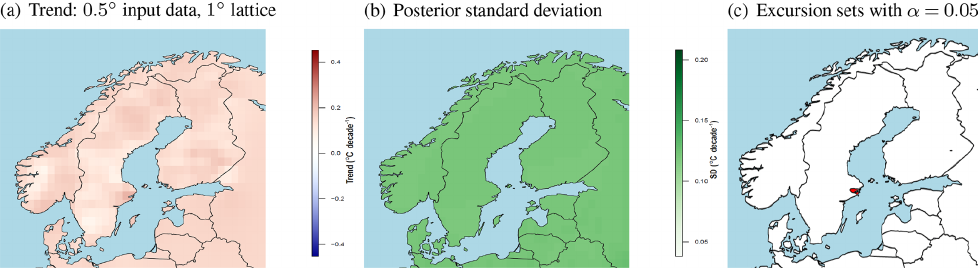
Figure 2. Trend estimates for Fennoscandia based on input data on a 0.5 ◦ grid. (a) Posterior mean estimates of the trend coefficient (in ◦ Cdecade − 1 ) projected on a regular 1 ◦ lattice. (b) Posterior standard deviation of the trend coefficient on the same lattice. (c) Avoidance excursion set where the spatial null hypothesis of no trend is rejected for the level α = 0 . 05 (red). Note that the estimates outside Fennoscandia are based on extrapolation of the data for these three countries.